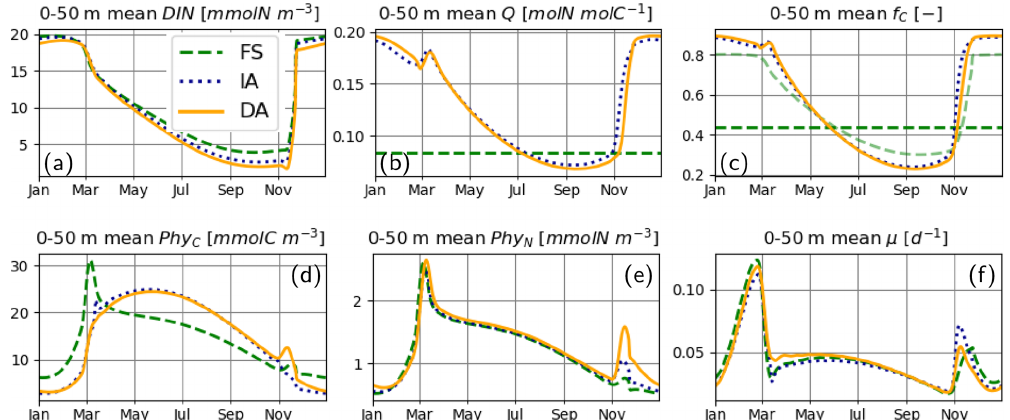
Figure 7. Upper 50m averages of critical variables. (a) DIN [mmolNm − 3 ], (b) phytoplankton Q [mmolNmmolC − 1 ], (c) f C [–] (in addition L N [–] for FS, shown with pale broken line), and (d) Phy C [mmolCm − 3 ], Phy N [mmolNm − 3 ] (e) , and µ [d − 1 ] (f) , as simulated by the FS (dashed green line), IA (fine-dashed dark blue line) and DA (continuous orange line) variants.